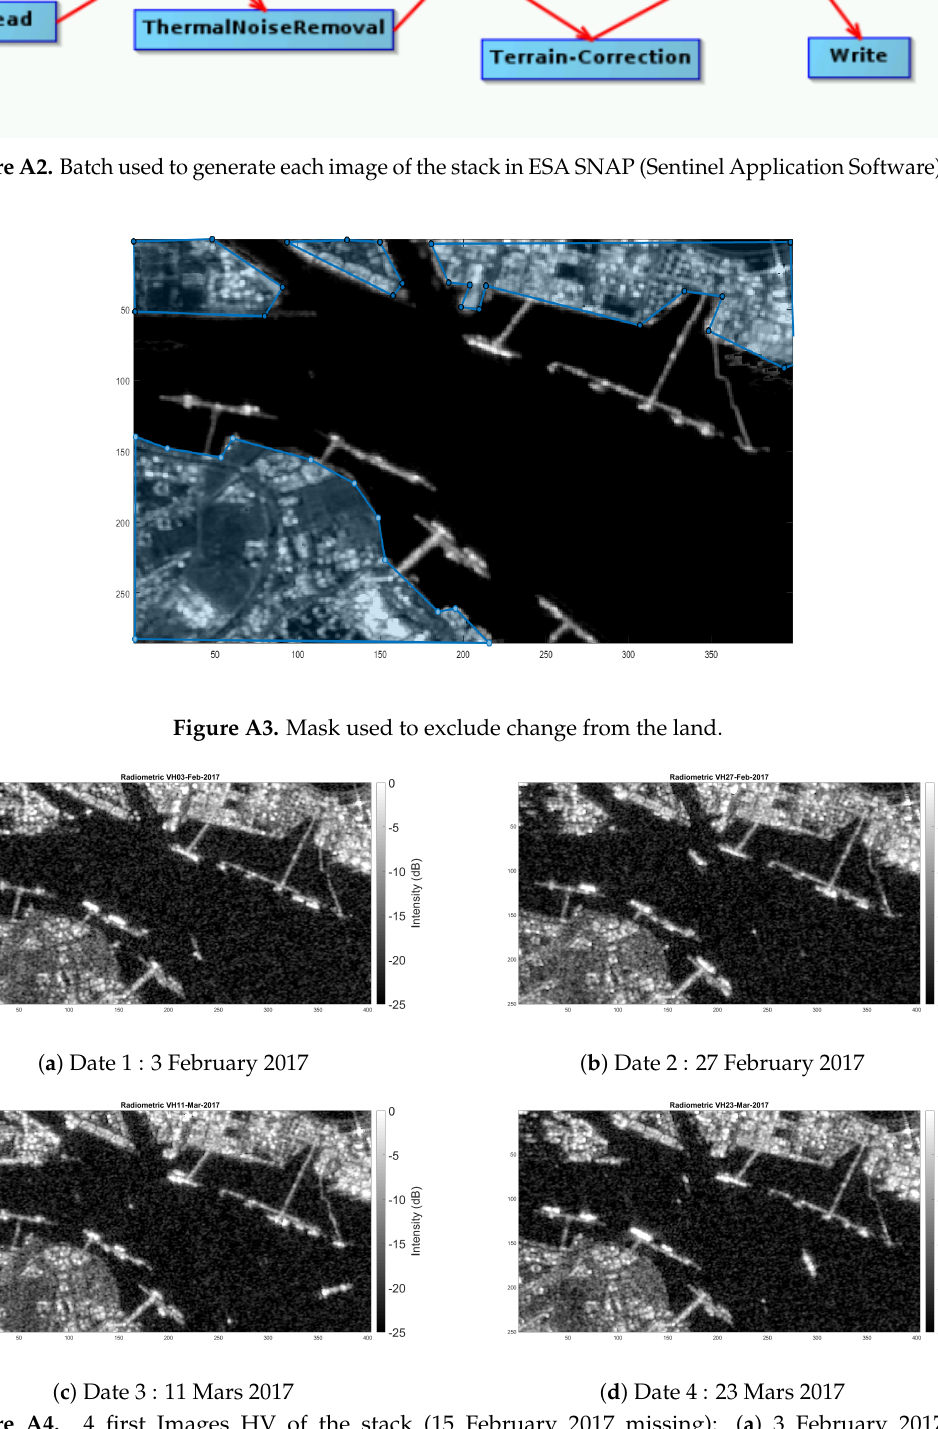
Figure A4. 4 first Images HV of the stack (15 February 2017 missing): ( a ) 3 February